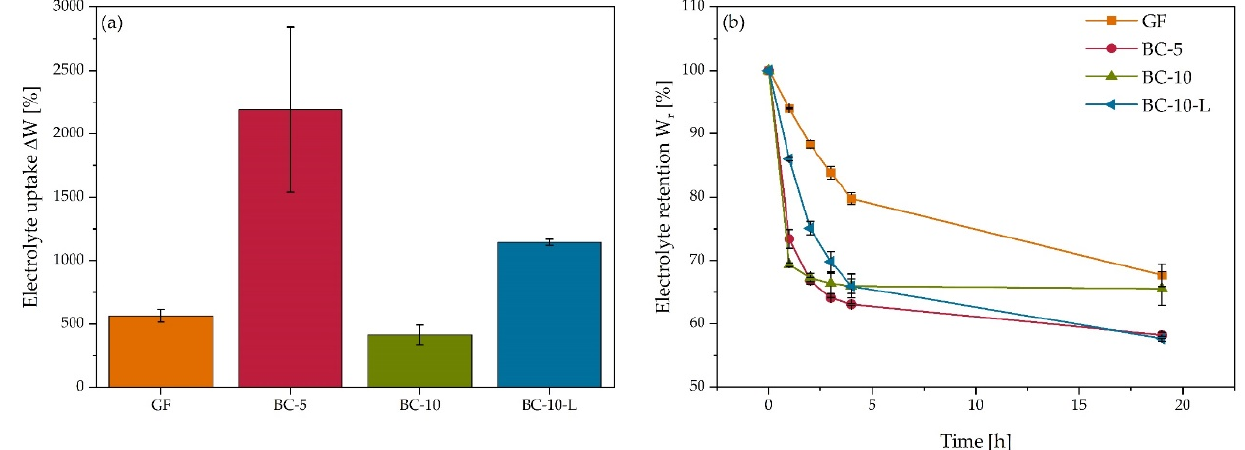
Figure 4. ( a ) Electrolyte uptake and ( b ) retention for a glass-fiber (GF) and bacterial cellulose (BC)- based separators after soaking in alkaline electrolyte. based separators after soaking in alkaline